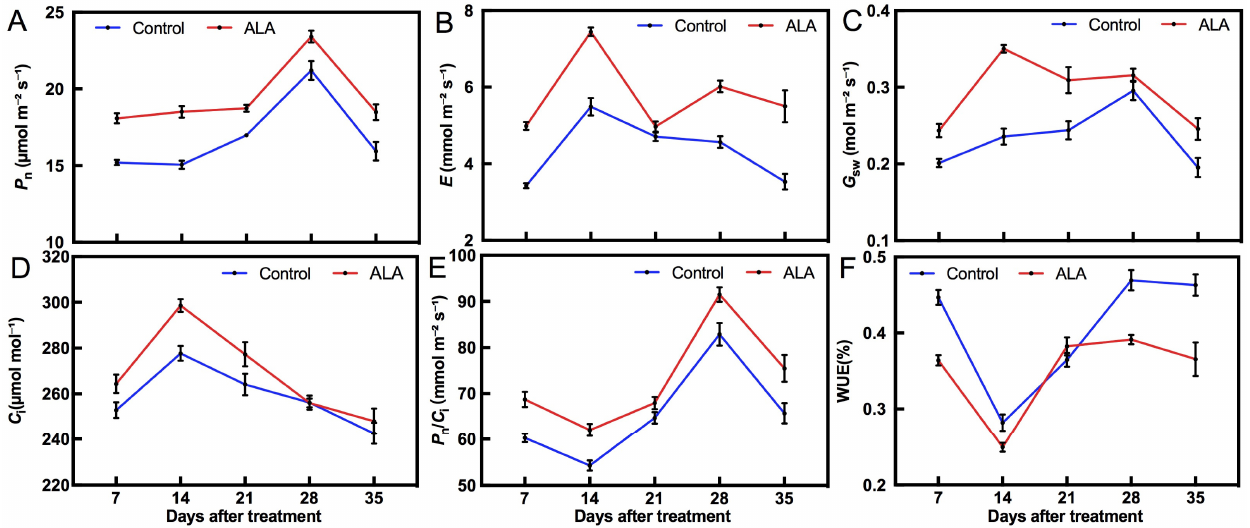
Figure 1. Effect of ALA treatment on photosynthetic gas exchange parameters of nectarine leaves. ( A ) P n , net photosynthetic rate. ( B ) E , transpiration rate. ( C ) G sw , stomatal conductance to water vapor. ( D ) C i , intercellular CO 2 concentration. ( E ) P n / C i , instantaneous carboxylation efficiency. ( F ) WUE, water use efficiency. The data are the means ± standard error of twenty biological